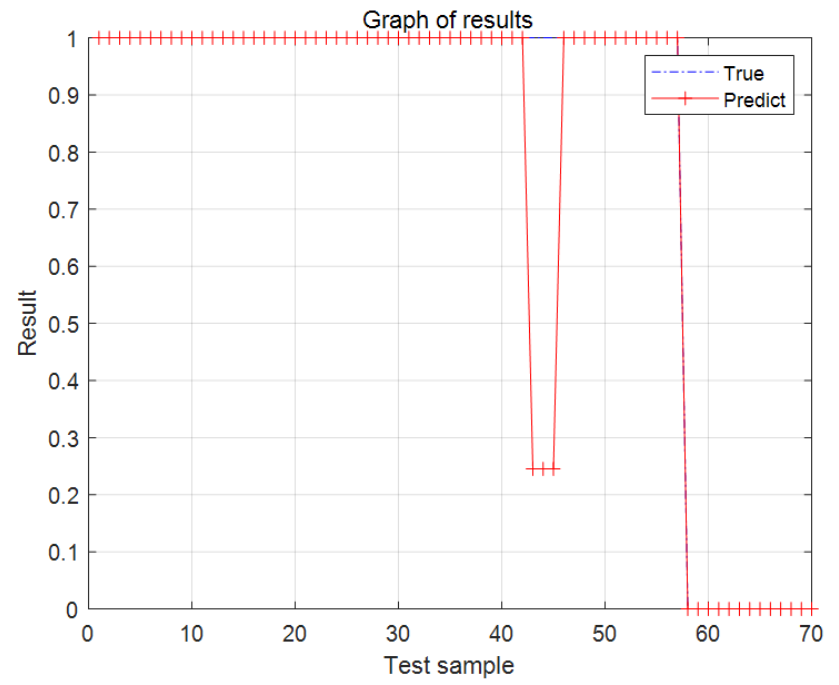
Figure 10. Plot of RBF model fits after process.